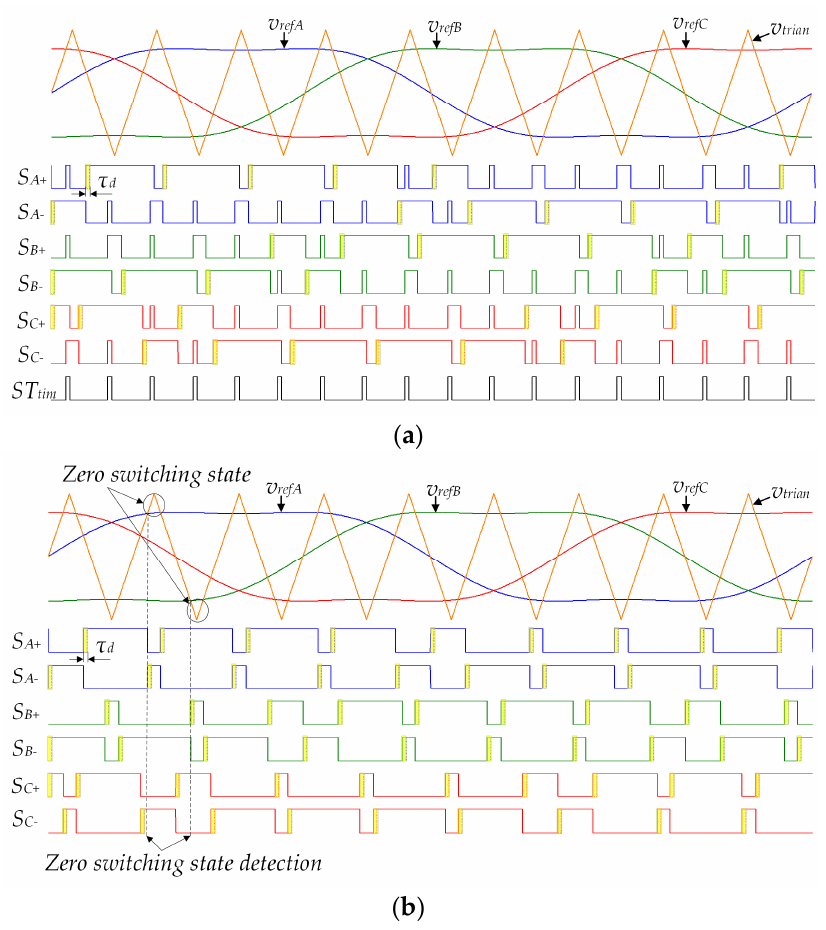
Figure 16. Waveforms of the modified zero-sync method of the STS injection where 0 < D 0 < D 0, max ( a ), waveforms of the SPWM with the dead-time where the STSs were omitted ( b ).